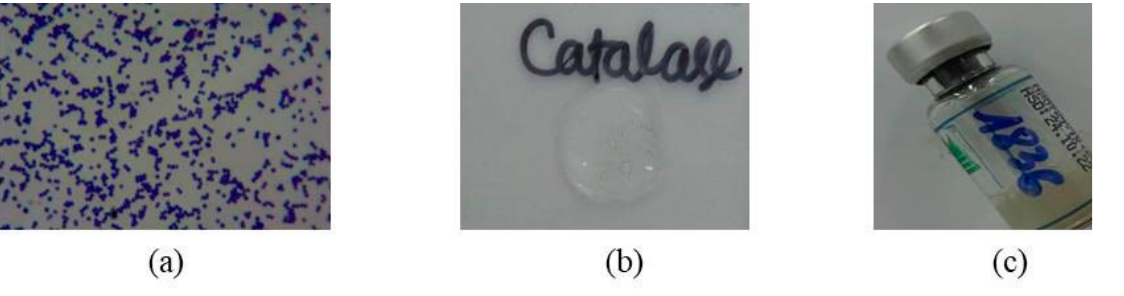
Figure 1. Result of culture isolates of Staphylococcus aureus from a boy aged 7 months old in this study. ( a ). Gram (+) cocci staining; ( b ). Catalase (+); ( c ). Coagulase (+). MRSA strains were identified when cefoxitin MIC ≥ 8 mcg/mL [6].